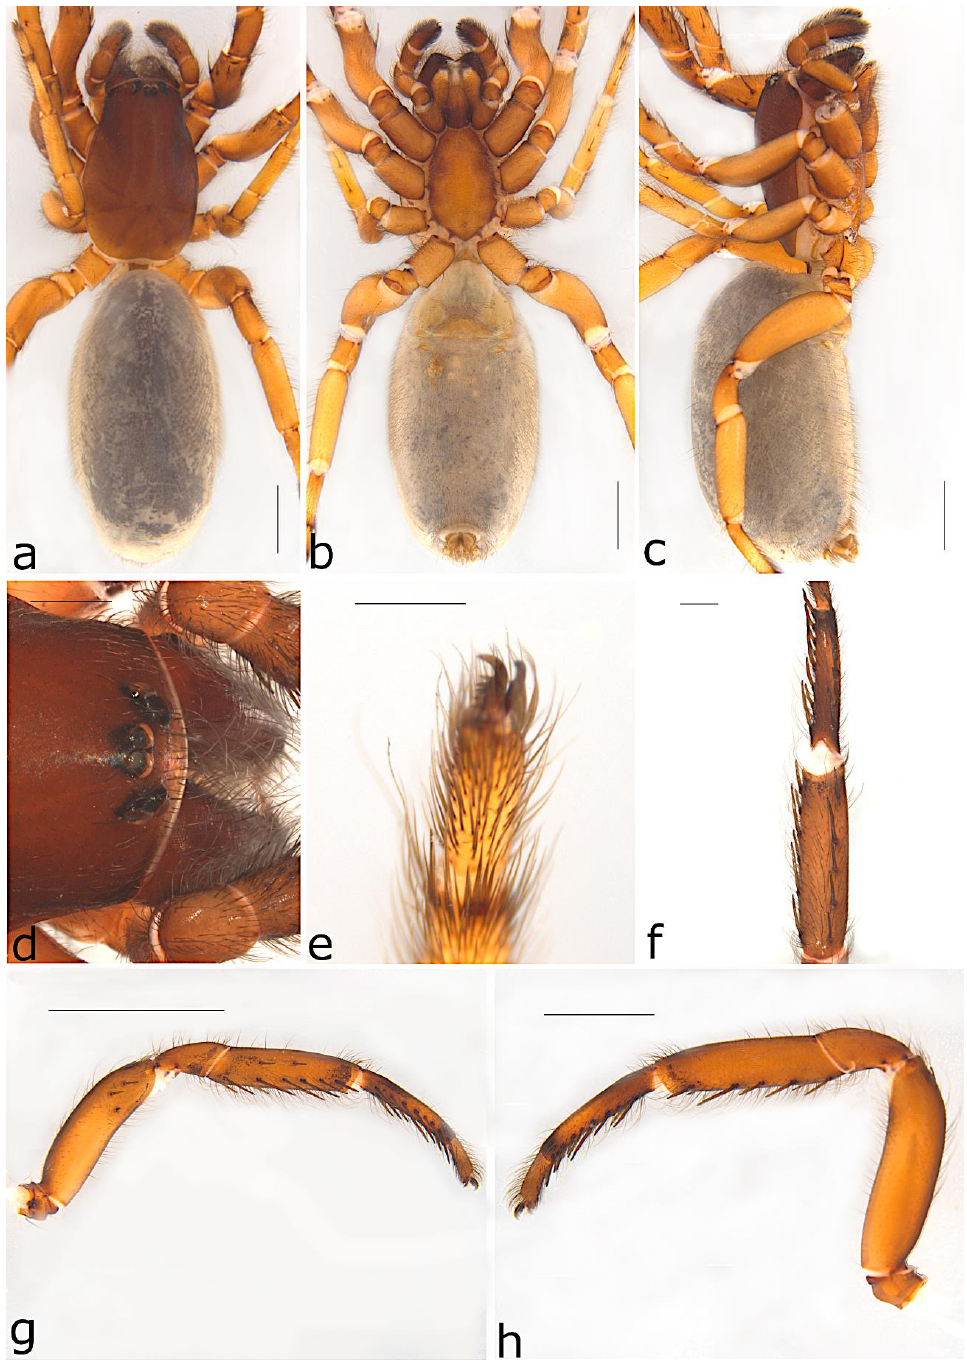
Figure 59. Ariadna tangara Marsh, Baehr, Glatz & Framenau, 2018. ♀ holotype (SAMA NN29864) from Kangaroo Island (SA): ( a ) habitus, dorsal view; ( b ) same, ventral view; ( c ) same, lateral view; ( d ) eyes, dorsal view; ( e ) left metatarsus IV, preening comb, retrolateral view; ( f ) left leg I, ventral view; ( g ) same, prolateral view; ( h ) same, retrolateral view. Scale bars ( a – c ) = 1 mm, ( d – f ) = 0.5 mm, ( g ) = 2 mm and ( h ) = 1